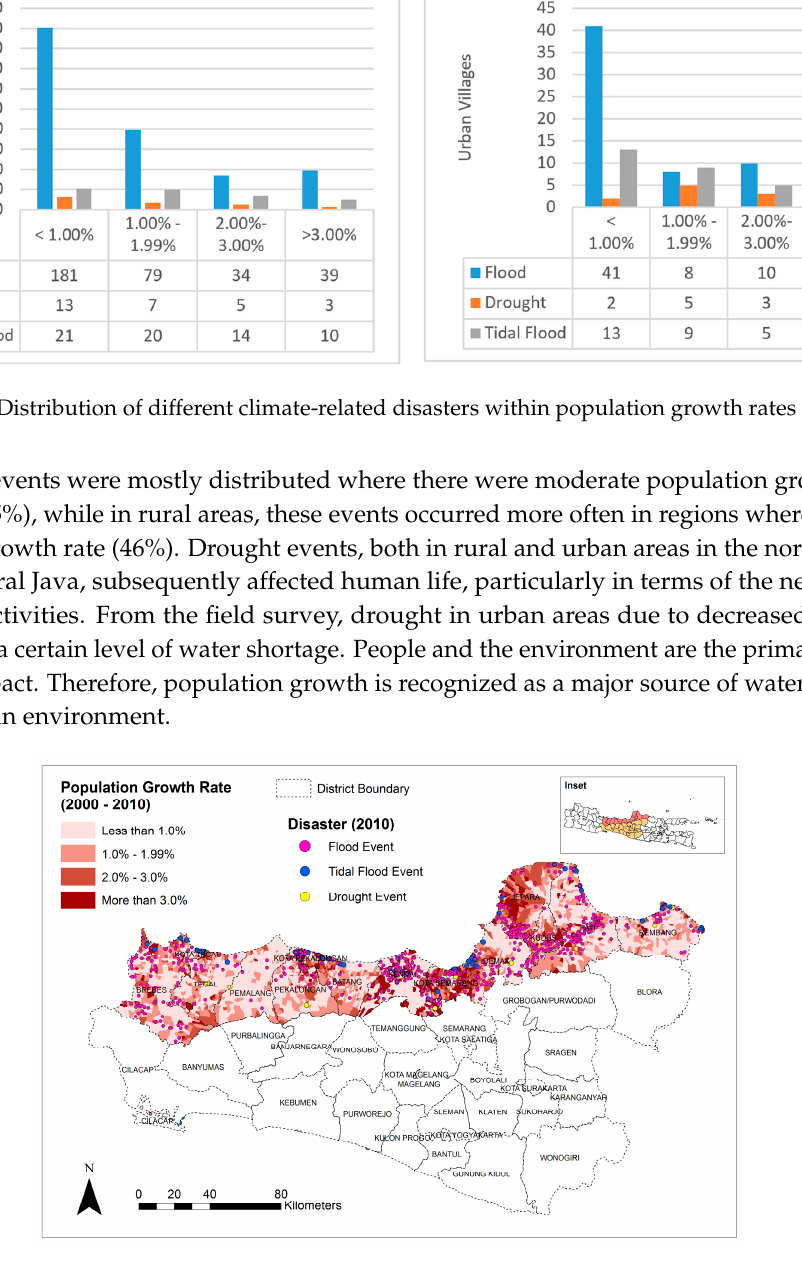
Figure 7. Spatial Distribution of different climate-related disasters within population growth rates in 2010.